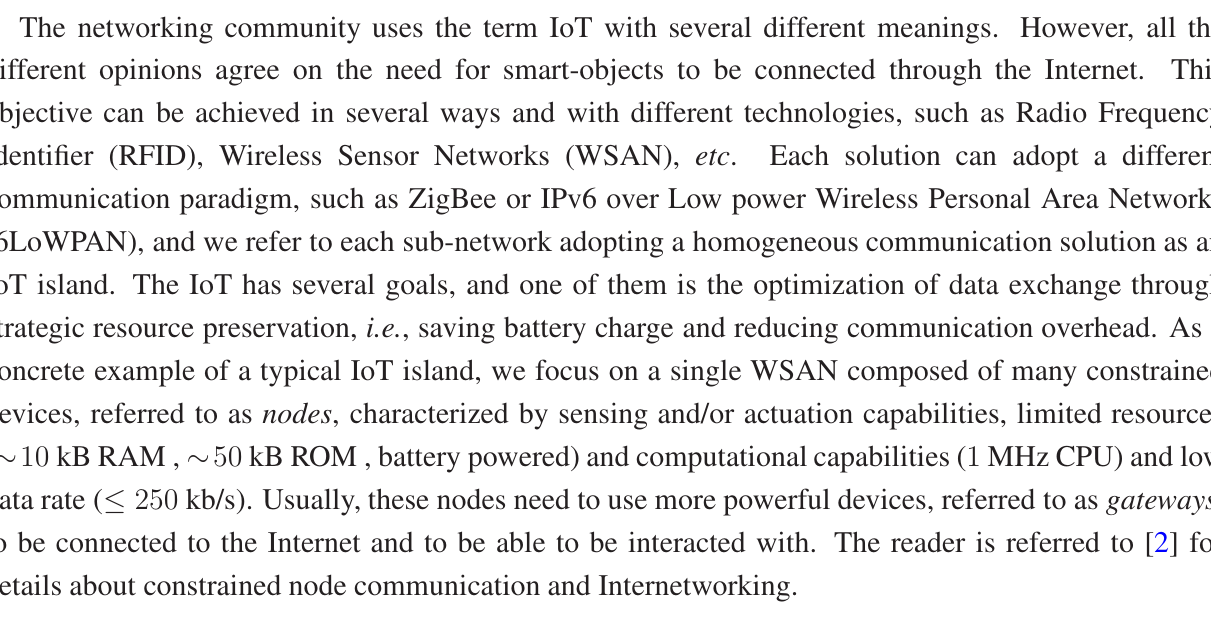
Figure 1. Schematic diagram of a simple Internet of Things (IoT) network: blue circles and the red square represent sensor nodes and a gateway node,